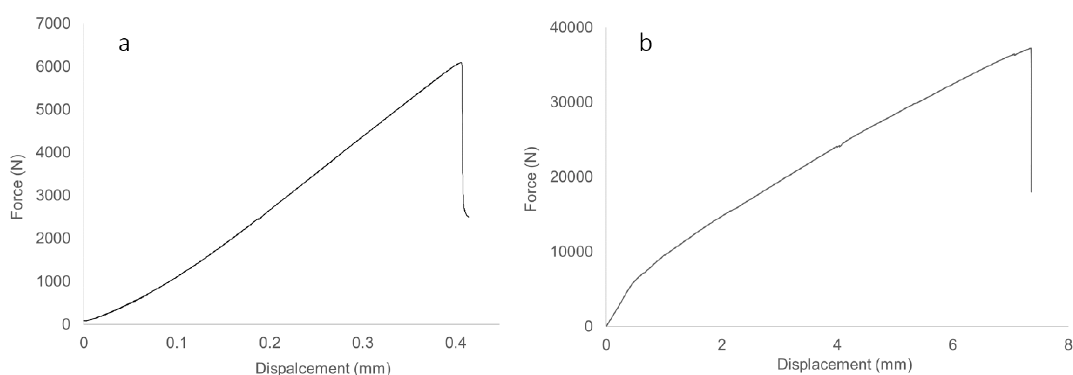
Figure 17. Typical load displacement curves for ( a ) non-reinforced and ( b ) bamboo composite reinforced concrete beam.